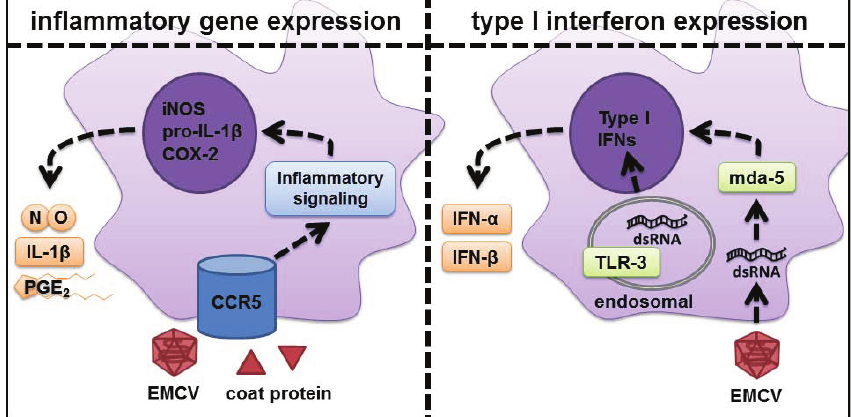
Figure 2. Differential responses of macrophages to EMCV infection. EMCV stimulates the activation of pro-inflammatory signaling within minutes and these pathways regulate the transcriptional activation of inflammatory genes (iNOS, COX-2, and IL-1(cid:3)) during viral infection. This pro-inflammatory response does not require the presence of dsRNA sensors or dsRNA sensor-dependent type I IFN production. It is hypothesized that this inflammatory cascade serves to maintain macrophage survival, limit replication of the pathogen, and to inform neighboring cells that a pathogen is in the vicinity. These events afford time for the innate immune response to identify the pathogen through a PRR and activate a more selective, secondary response that in the case of viral infection includes the expression and production of type I IFNs in response to viral dsRNA replicative